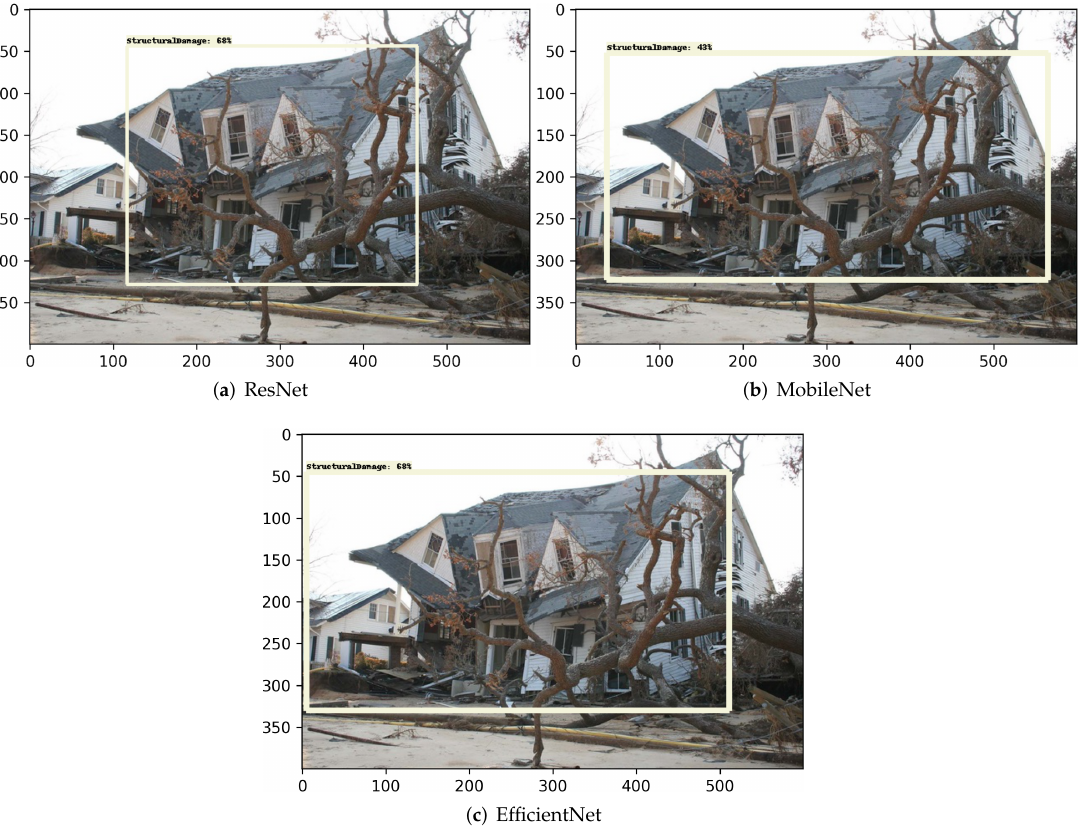
Figure 9. Inference carried out on the image of structural damage for each of the three models. The tan colored bounding boxes correspond to the correct predictions of structural damage from the first row of Table